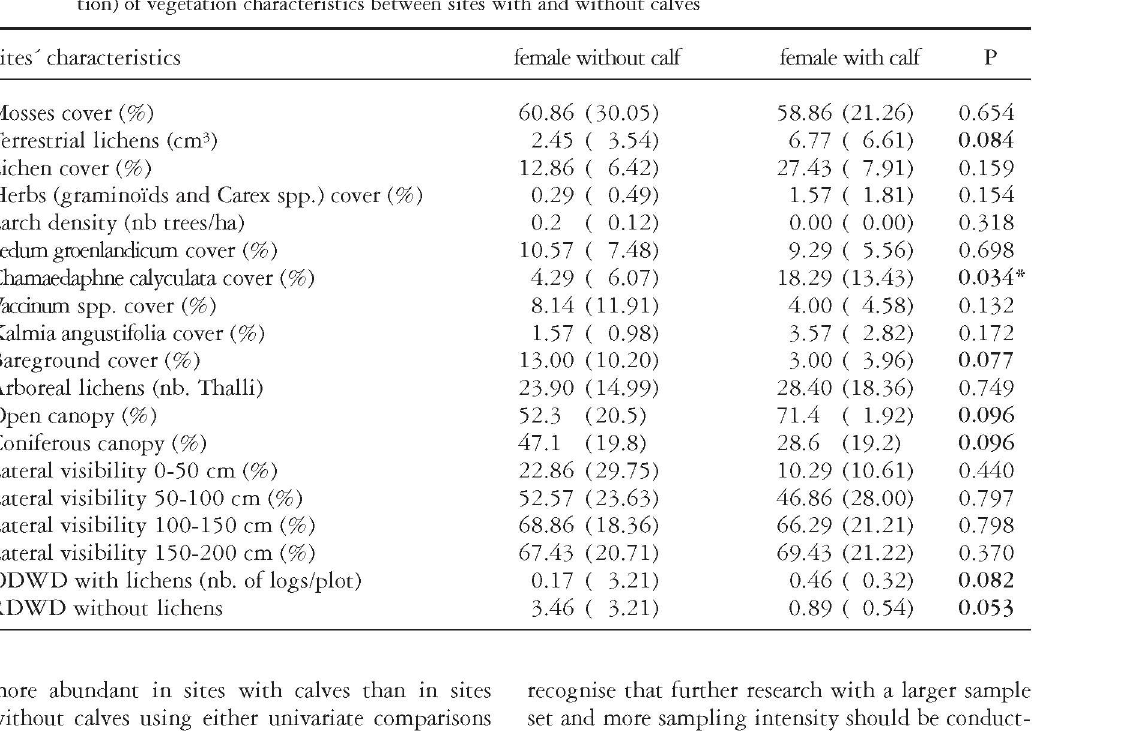
Table 2. Results of Mann-Whitney U-test, at a=0.05 (bold with*) and a = 0.1 (bold), for mean values (standard devia¬ tion) of vegetation characteristics between sites with and without